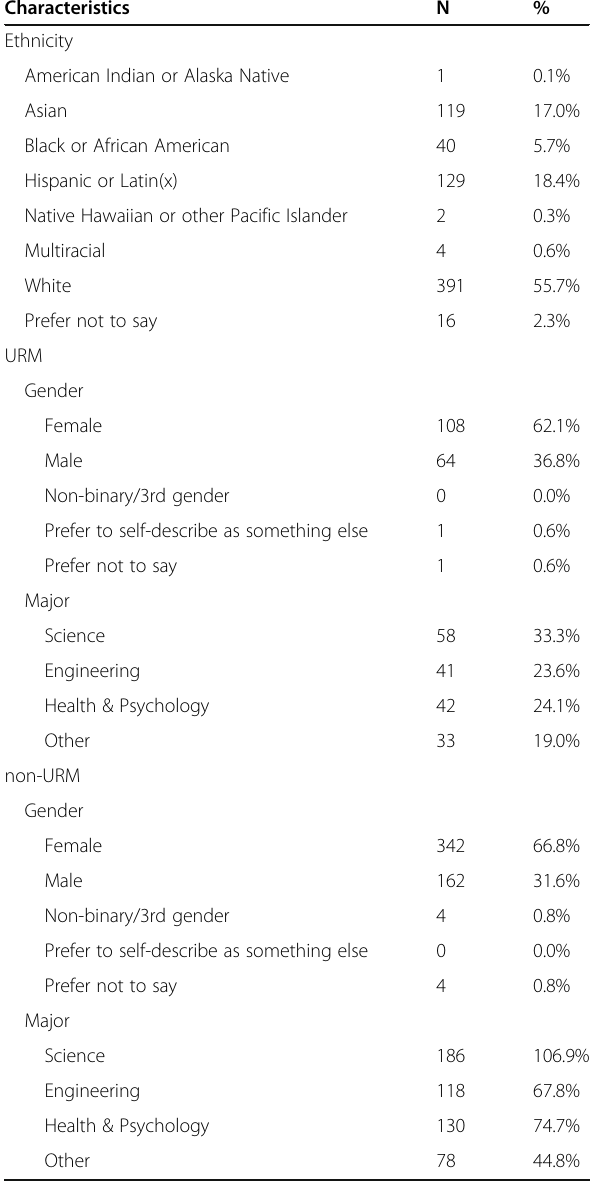
Table 2 Summary of participant